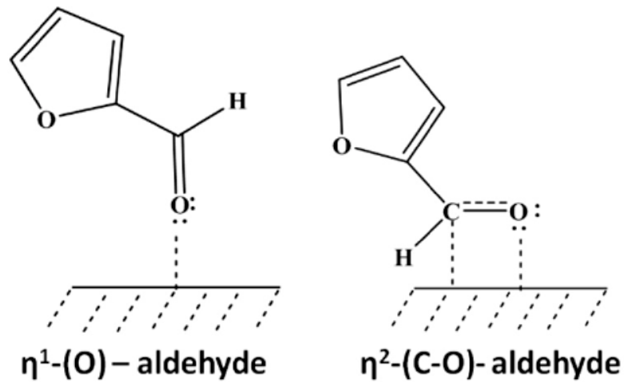
Figure 3. Modes of FFR adsorption on catalyst surfaces. Adapted from